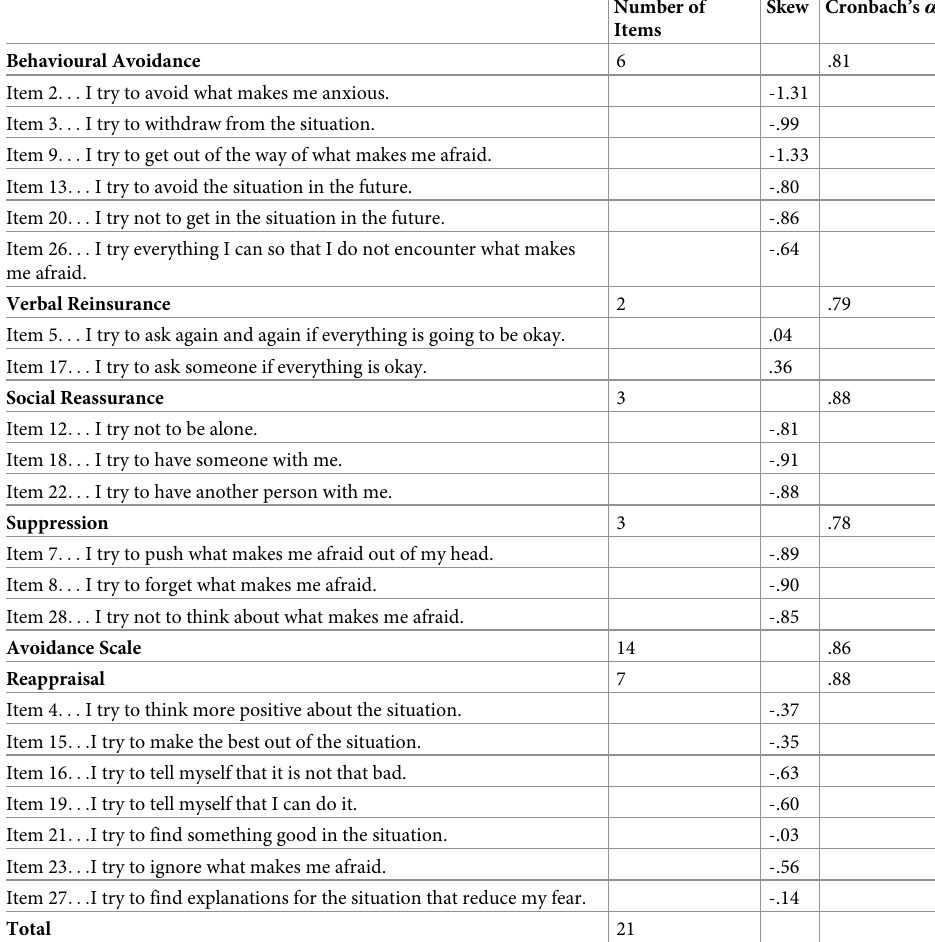
Table 3. Overview of the 21-item, five-factor version of the Bochum Assessment of Avoidance-based Emotion Regulation for Children